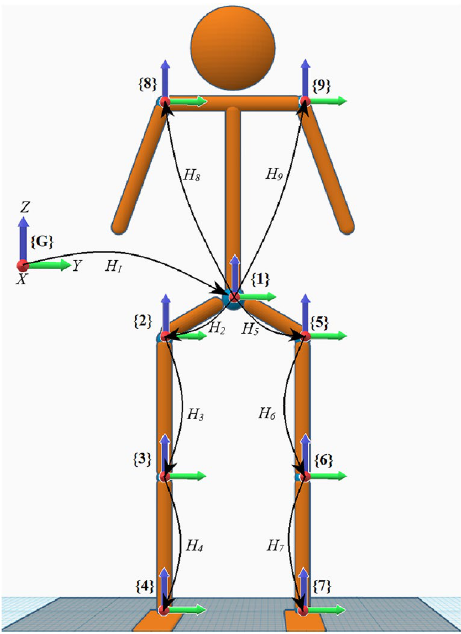
Figure 1. Nine joints—Nineteen DoF biomechanical model. ‘G’ represents the global frame of reference and H i represents the homogeneous transformation matrix used to describe the spatial relationship between consecutive